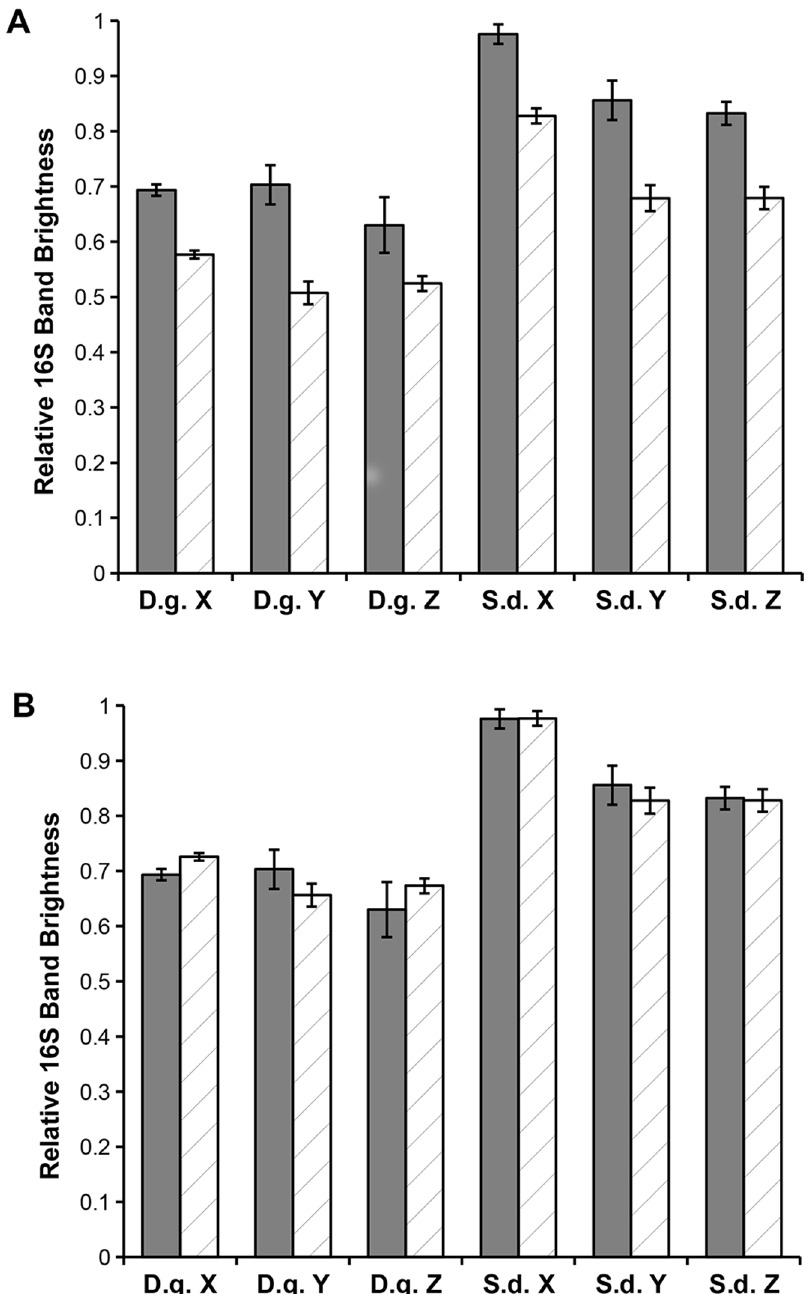
Figure 6. Assay Measurements from cDNA Template reflect Original Culture Composition. A The unadjusted cDNA results show a significant difference between gDNA and cDNA results (F 5,57 =13.83, P , 0.001). B Applying a 0.149 adjustment to the cDNA results show no significant difference (F 5,57 =1.06, P=0.403) between gDNA and cDNA results. The bars show mean relative 16S band brightness ( 6 standard error) for either gDNA (grey bars) or cDNA (hatched bars) template from three D. grandis cultures (D.g. X, Y, Z) and three S. diplocostata cultures (S.d. X, Y, Z).